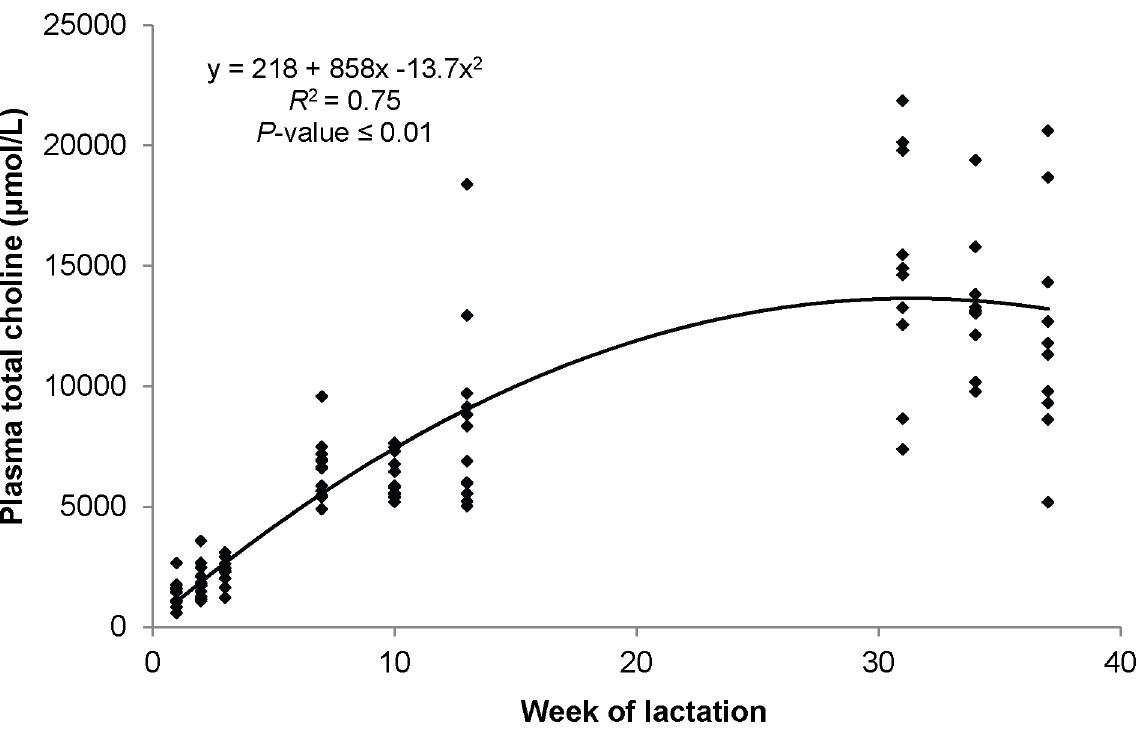
Figure 2. Relationship between total choline concentration in plasma and week of lactation. The standard errors for the intercept, linear and quadratic term were 564, 97.0, and 2.42, respectively.